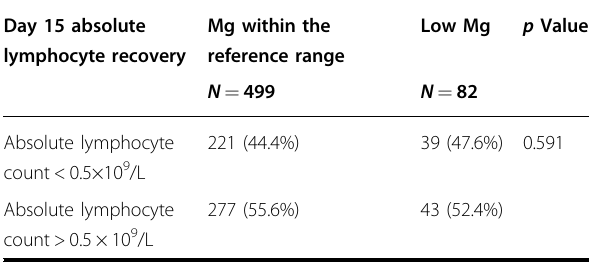
Table 3 Day 15 lymphocyte recovery by premyeloablative serum magnesium